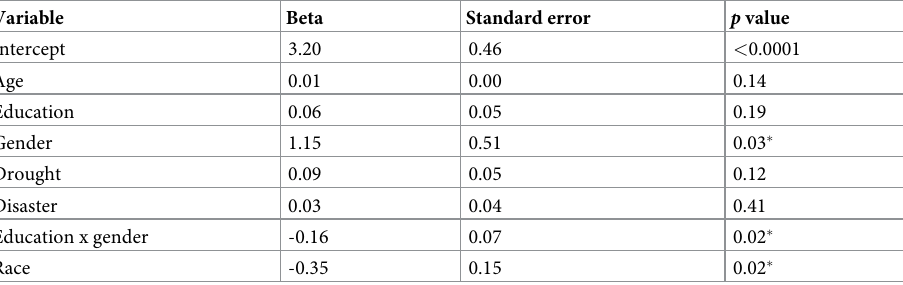
Table 1. Predictors of perceived climate change